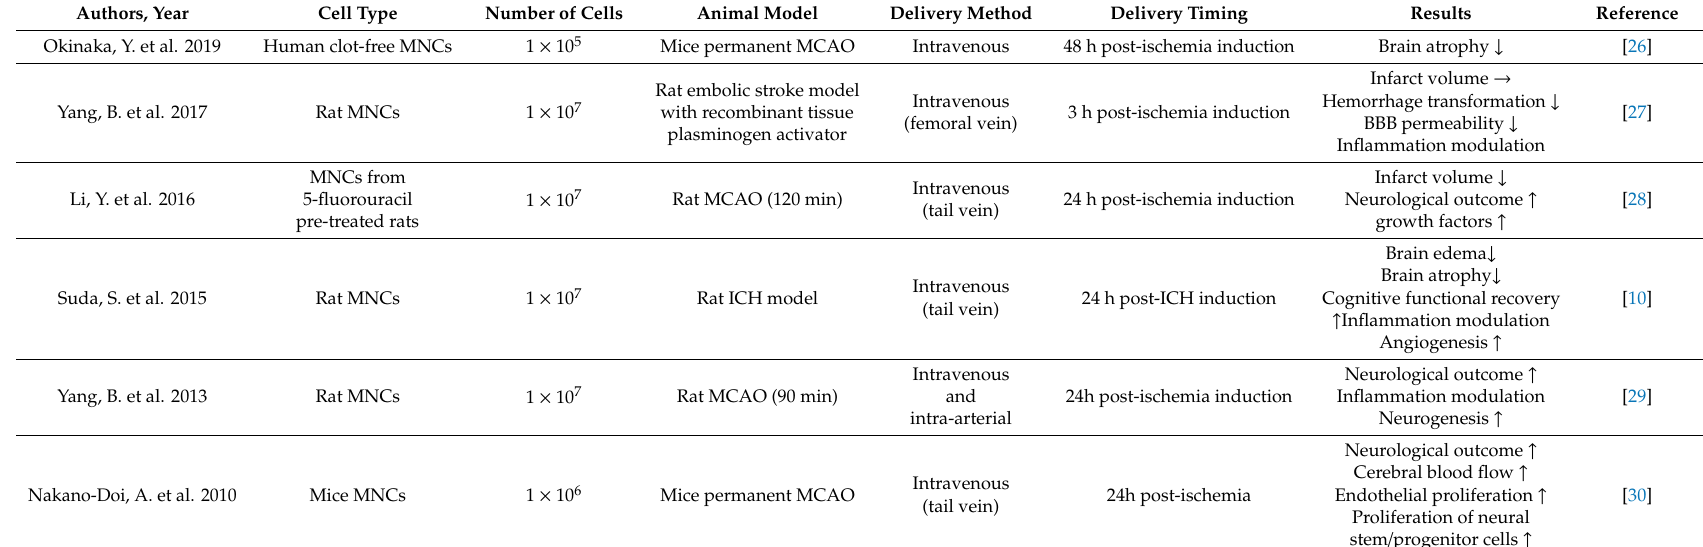
Table 1. Experimental study for the bone marrow mononuclear cells (MNCs) transplantation into ischemic brain injury in animal